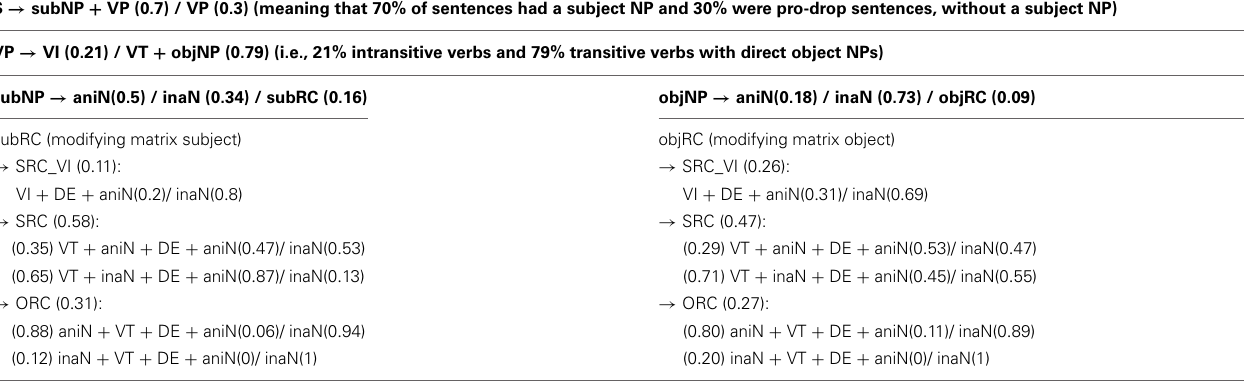
Table 4 | Finite state grammar with corpus-based bigram transitional probabilities. S → subNP + VP (0.7) / VP (0.3) (meaning that 70% of sentences had a subject NP and 30% were pro-drop sentences, without a subject NP) VP → VI (0.21) / VT + objNP (0.79) (i.e., 21% intransitive verbs and 79% transitive verbs with direct object